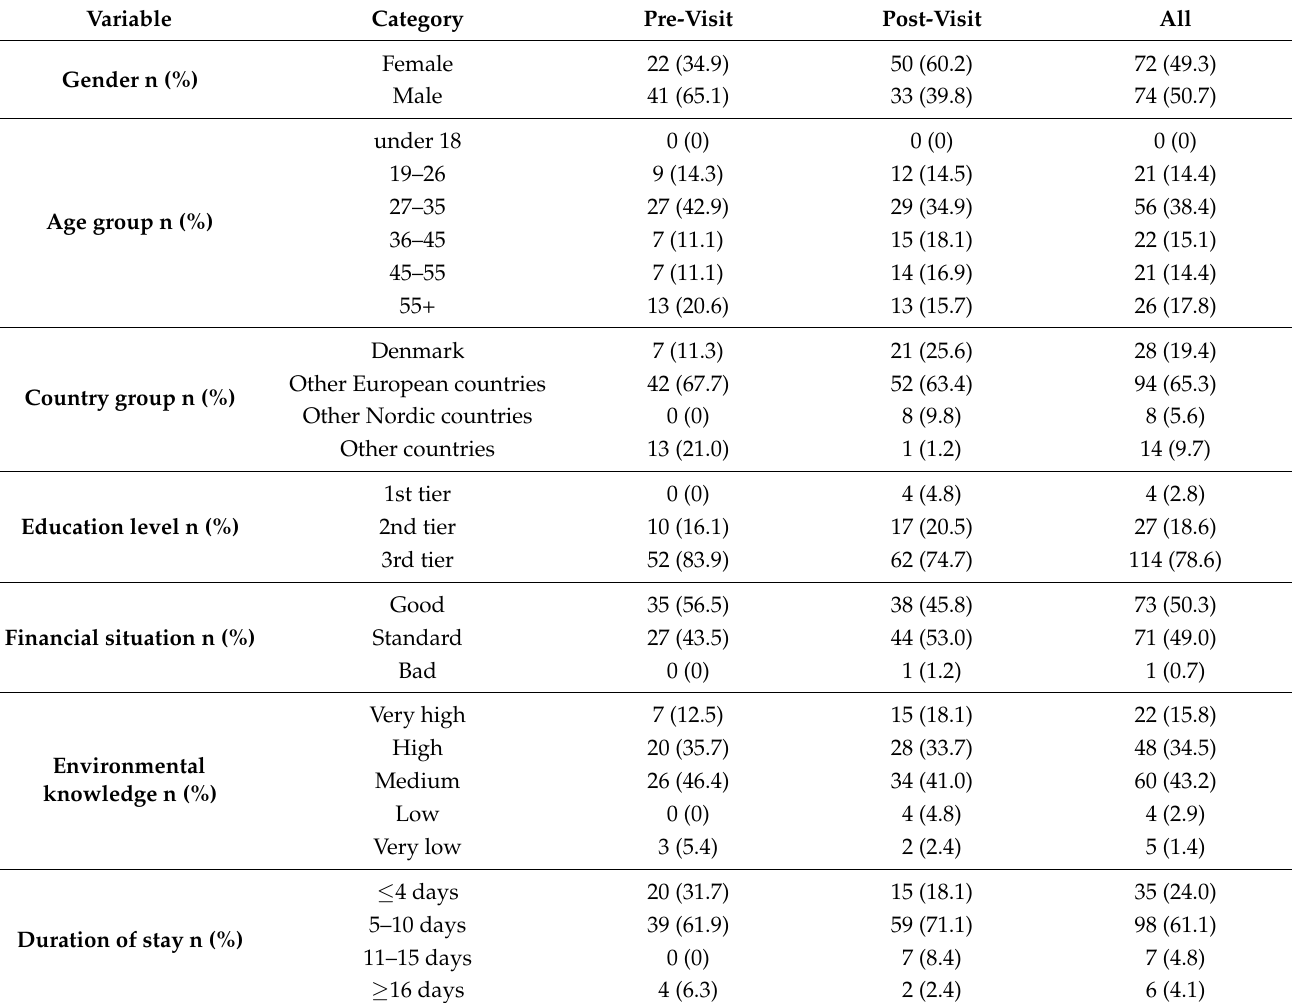
Table 1. Characteristics of the arriving and departing regular tourists, PS Imago Pro, own